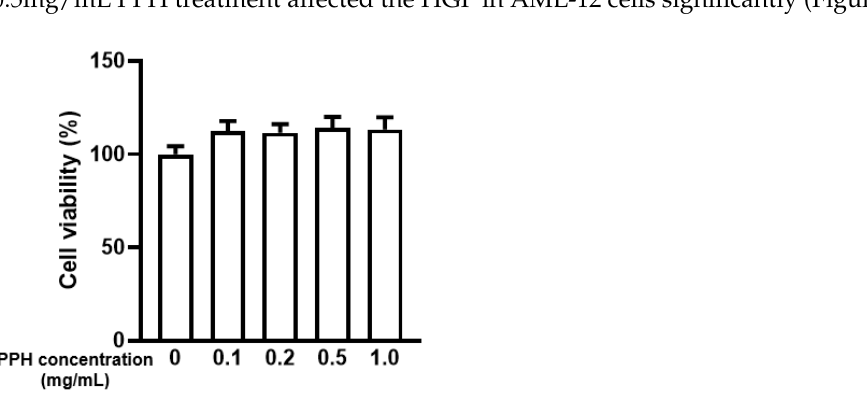
Figure 2. PPH did not show cytotoxicity in the AML-12 cells. AML-12 cells were treated with different concentrations of PPH for 24 h. The cell viability was evaluated using the CCK-8 assay. Data are expressed as mean ± SEM of 5 independent experiments.